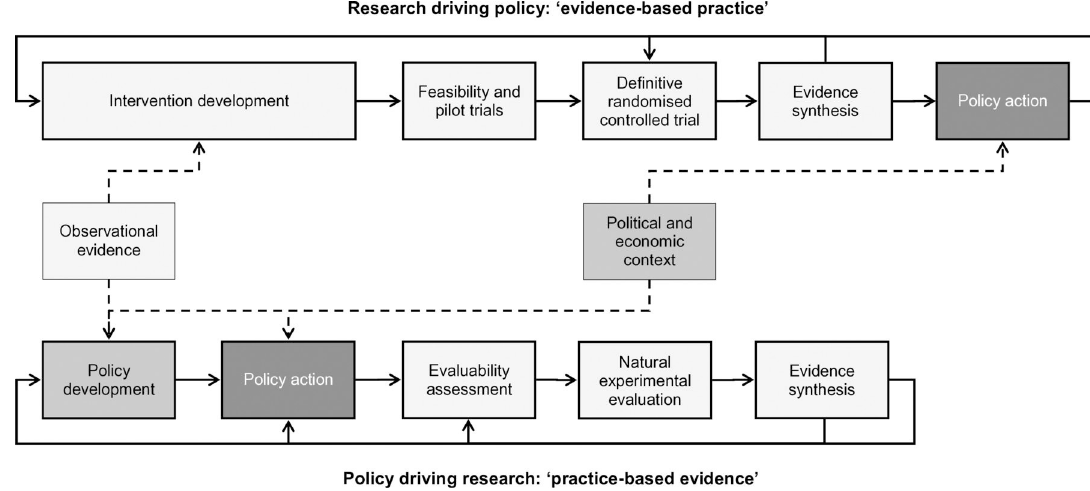
Fig 1. Ogilvie et al’s model of two complementary modes of evidence generation: evidence-based practice and practice-based evidence. Reproduced under CC-BY-4.0 licence from authors’ original [9].